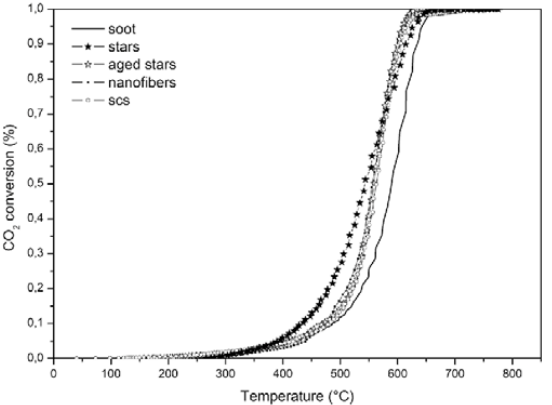
Figure 5. Total soot conversion in loose contact conditions. Reproduced from Ref. [92] with the permission from the Royal society of chemistry.